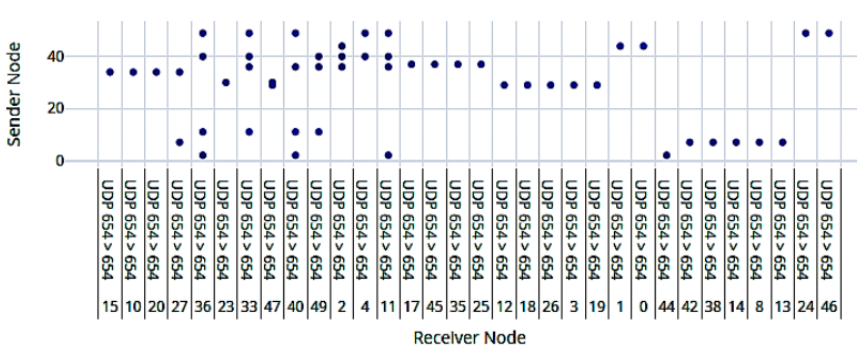
Figure 12. UDP Data Transmission.